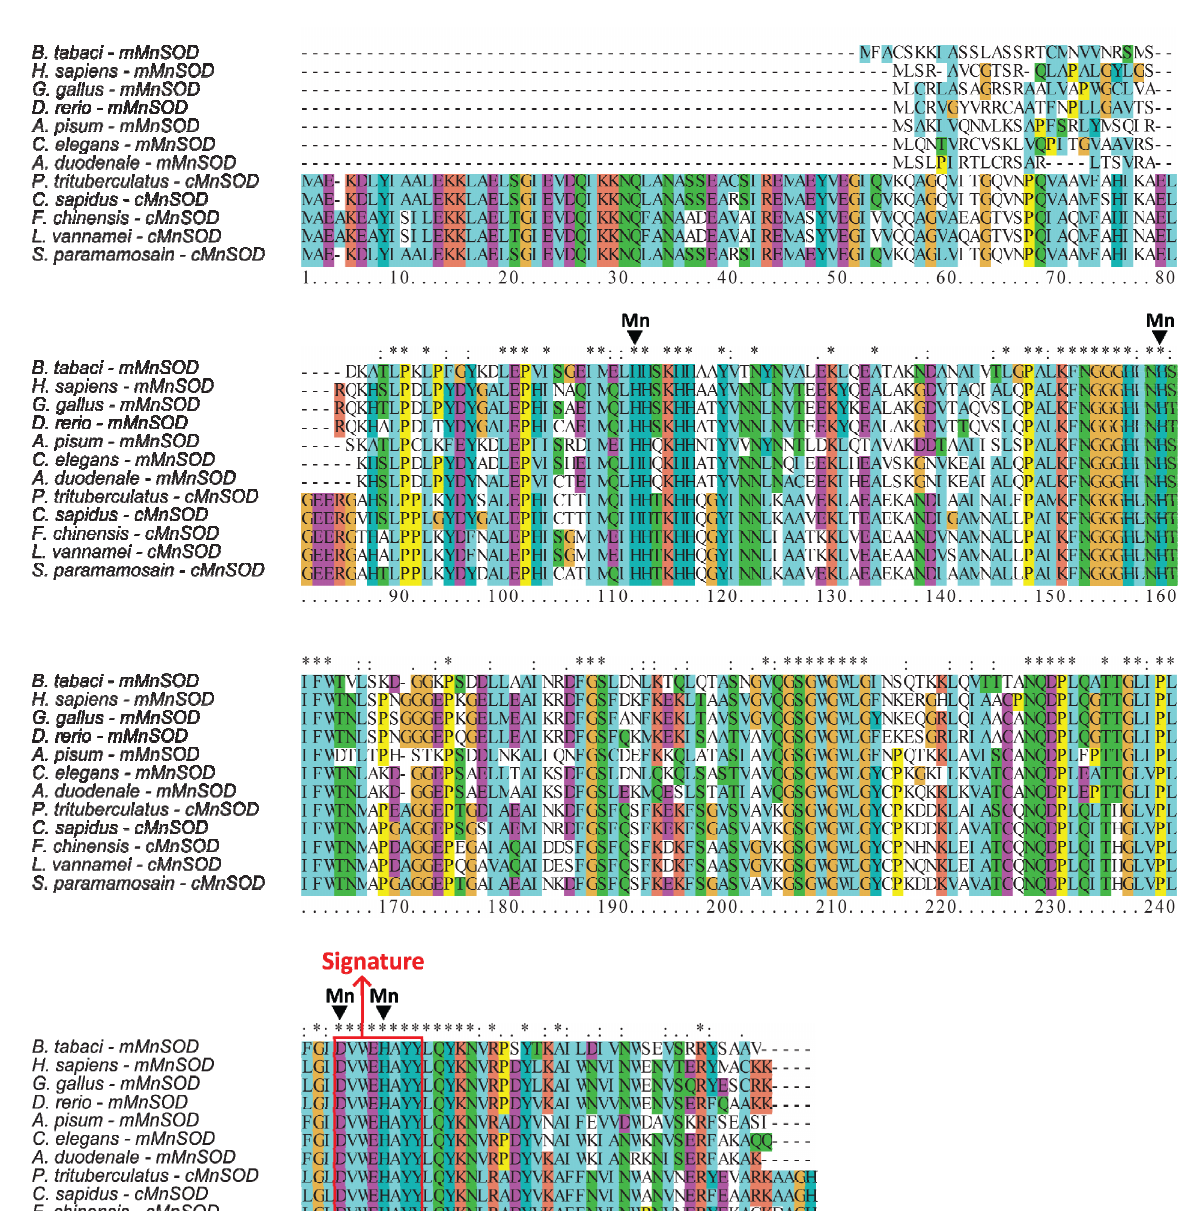
Figure 2. Multiple alignments of the deduced amino acid sequence of the Bt-mMnSOD with the mitochondrial MnSOD (mMnSODs) and cytosolic MnSOD (cMnSODs) of other species. The manganese superoxide dismutase signature DVWEHAYY is boxed in red (labeled Signature), and the amino acids required for binding Mn are indicated with